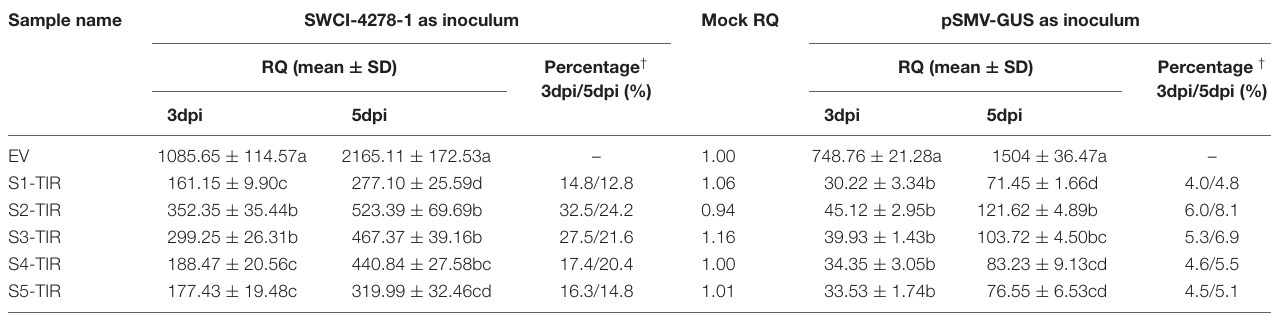
TABLE 2 | Relative quantification of viral RNA in N. benthamiana leaves for different TIR constructs.